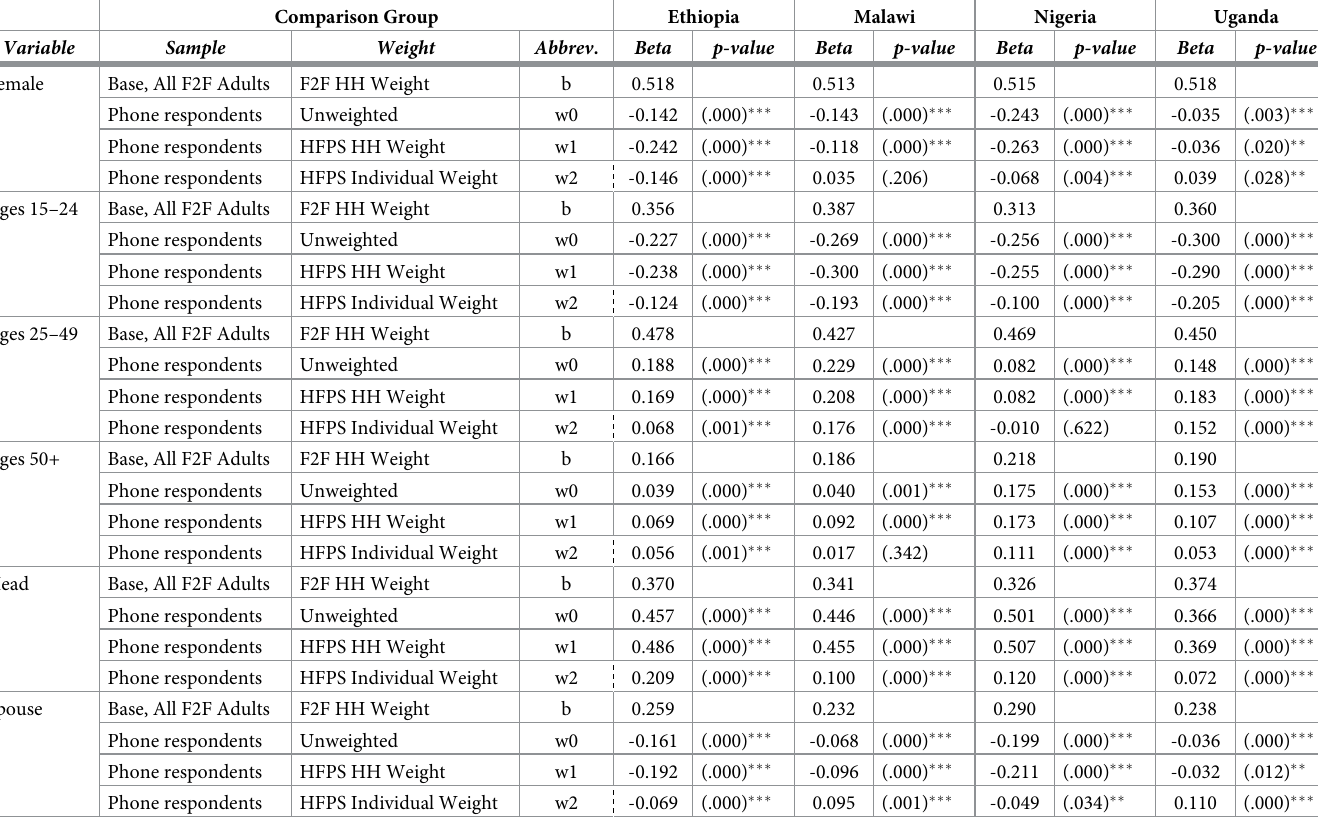
Table 4. Tests of mean differences between face-to-face (F2F) adults and phone respondents: Sex, age, relation to head–as measured in the F2F